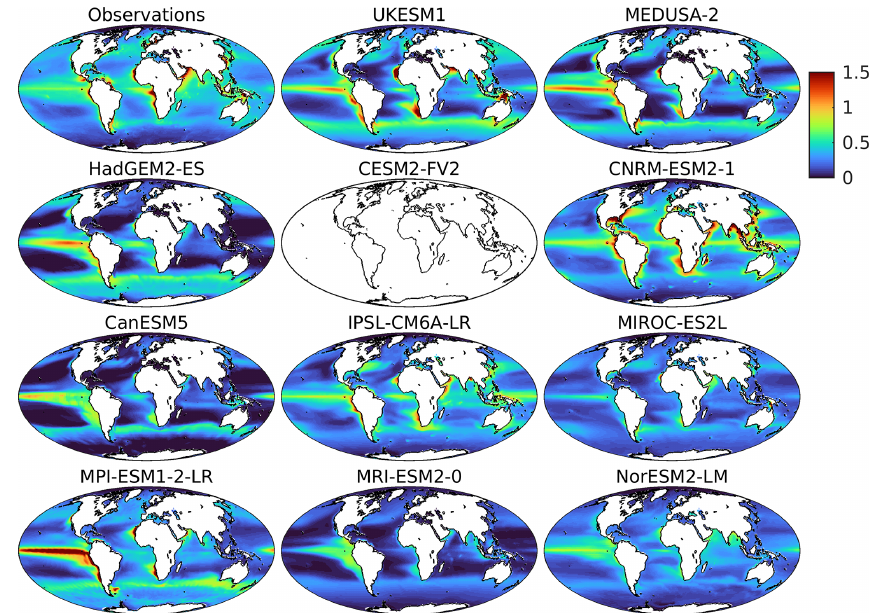
Figure 23. Intercomparison of annual mean vertically integrated primary production (CMOR variable intpp ) between observed (top row, left), UKESM1-simulated (top row, centre) and a range of comparable CMIP6 models (rows 2–4). Results from CMIP5’s precursor to UKESM1, HadGEM2-ES (Jones et al., 2011, row 2, left) and MEDUSA–2 (Yool et al., 2013, top row, right), are shown for comparison. This field was not available for the CESM2-FV2 model and thus has been left blank. Production is given in gCm − 2 d − 1